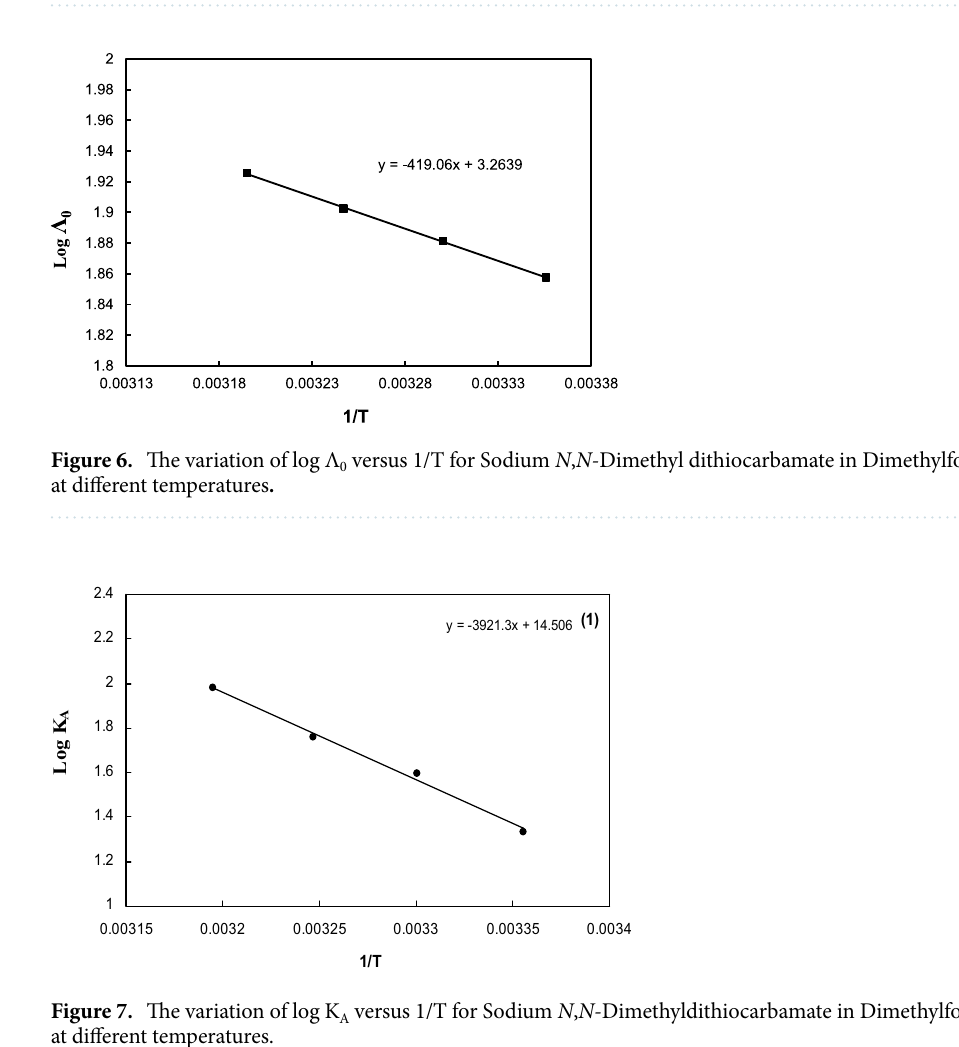
Figure 5. The multiple steps of association 14 .